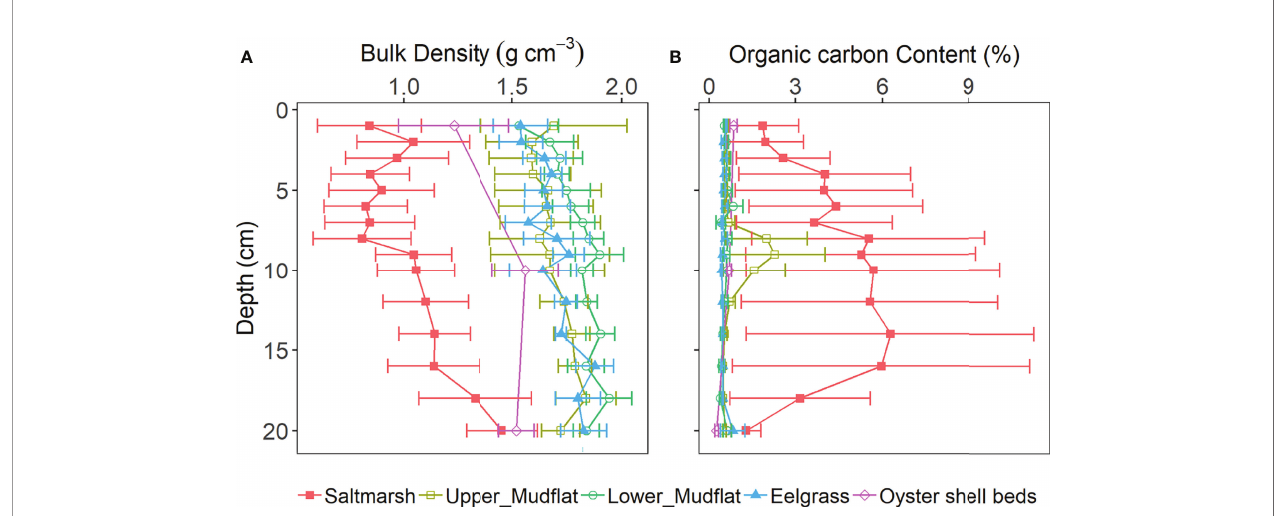
FIGURE 2 | Sediment core pro fi les of average (A) bulk density, and (B) carbon content (% by weight) in the top 20 cm of cores from salt marsh (n = 4), upper mud fl at (n = 6), lower mud fl at (n = 5), eelgrass (n = 3), and oyster shell bed (n = 2) stations at all sampling sites. All data are presented as the mean ± standard error of the